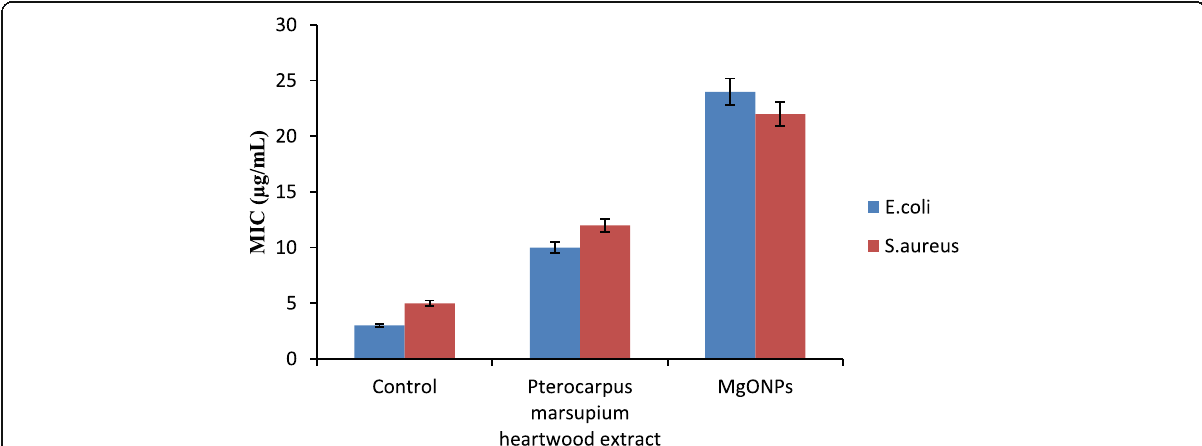
Fig. 8 Graphical representation showing minimum inhibitory concentrations of MgO-NPs synthesized from P . marsupium heartwood extract against E . coli and S .